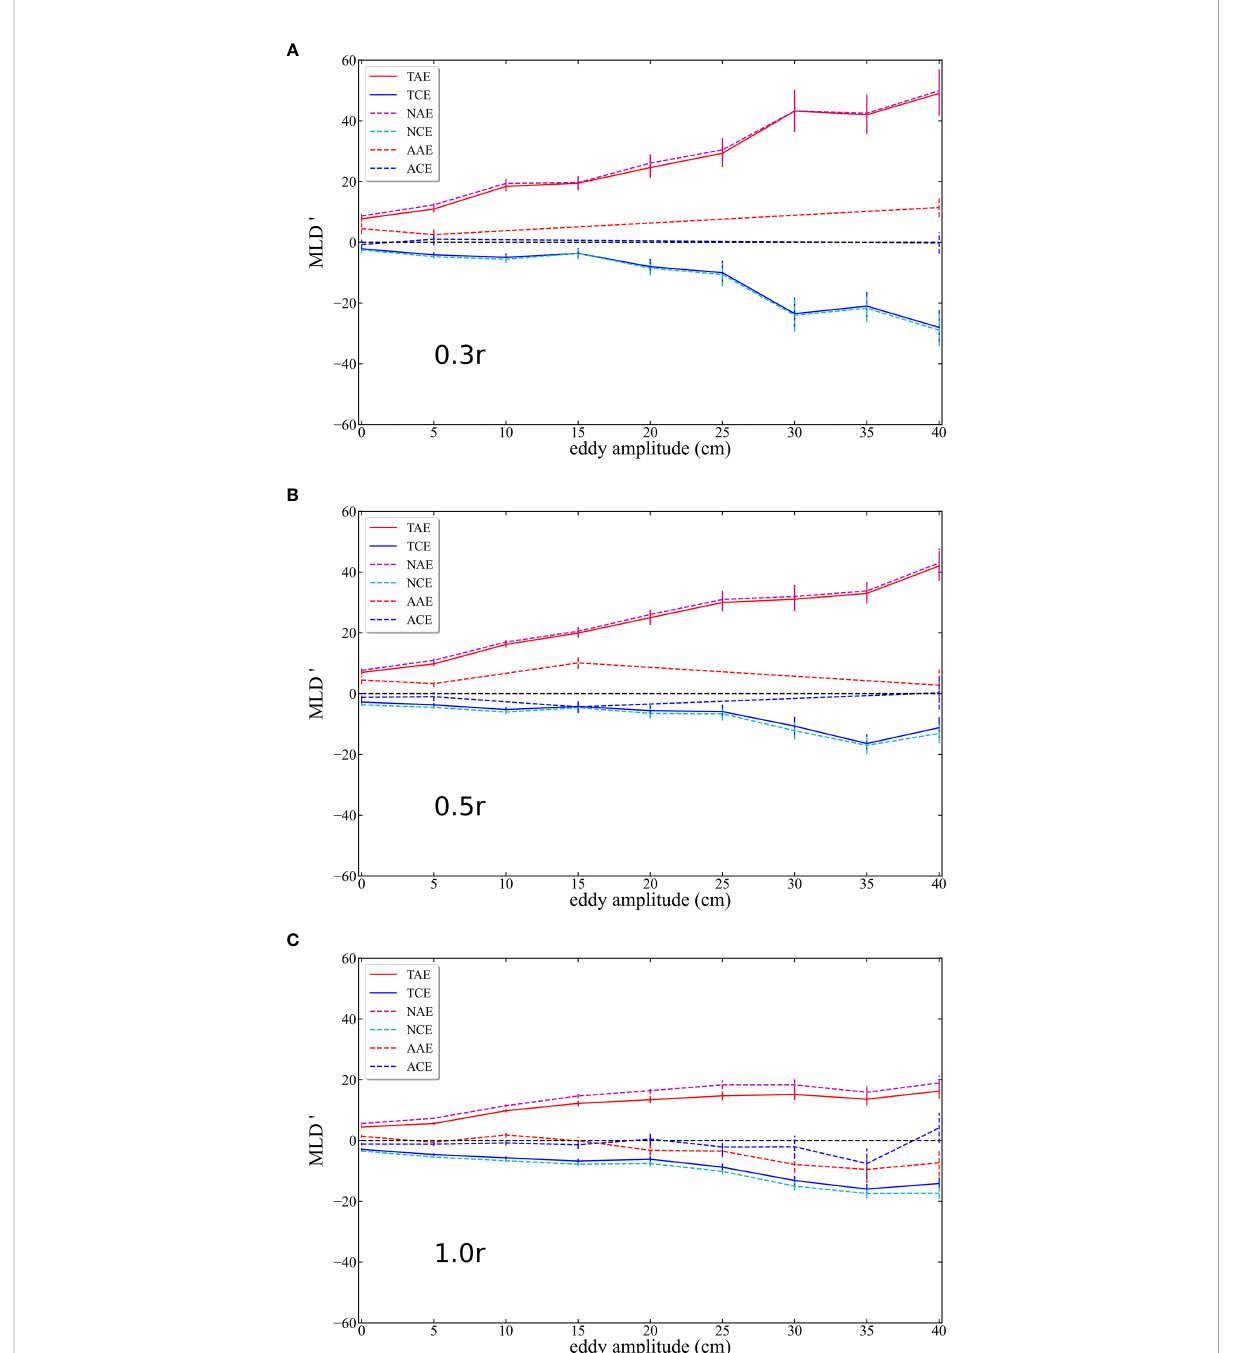
FIGURE 8 Average winter MLD anomalies (MLD anomalies) as a function of eddy amplitude. (A – C) mean 0.3r, 0.5r and 1r, respectively. TAE, TCE, NAE, NCE, AAE and ACE are represented by solid red, solid blue, dashed magenta, dashed cyan, dashed red and dashed blue respectively. MLD, mixed layer